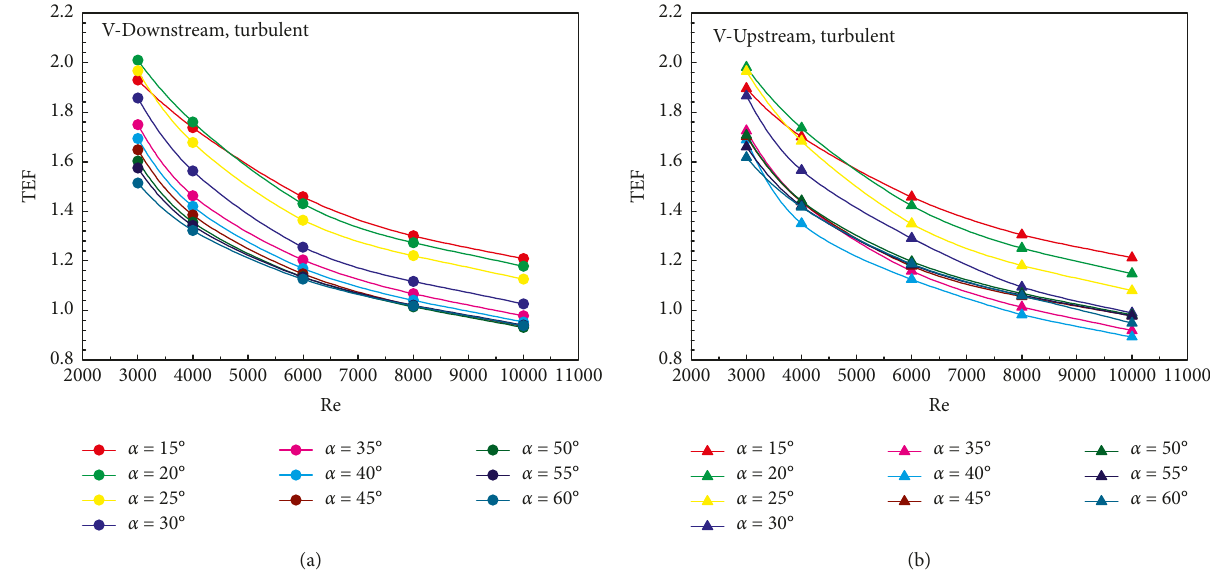
Figure 23: Relations of the TEF with Re for the heat exchanger tube inserted with the V-wavy surface for (a) V-Downstream and (b) V- Upstream at the turbulent